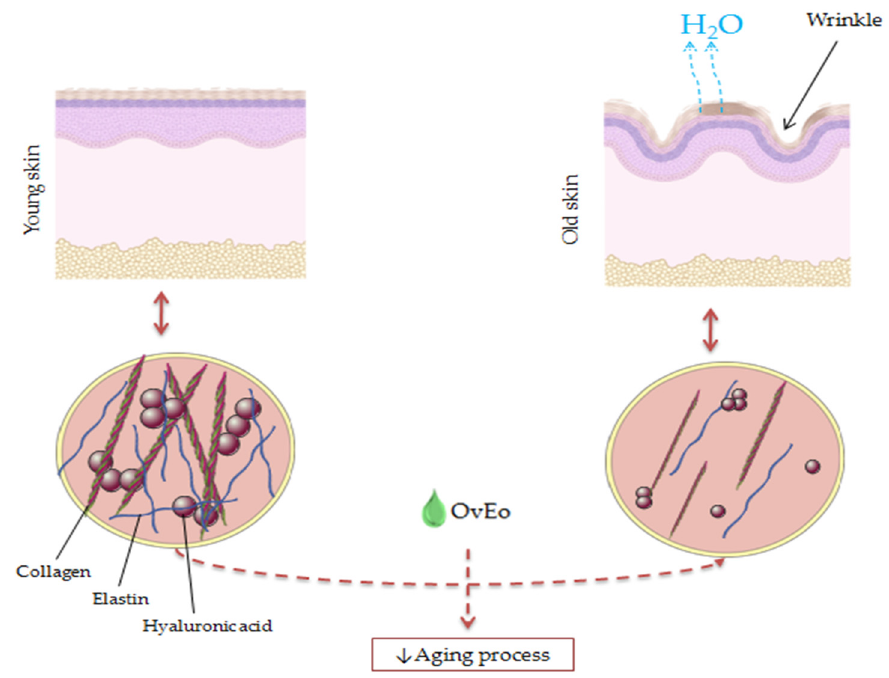
Figure 6. A snapshot of the antiaging effect of